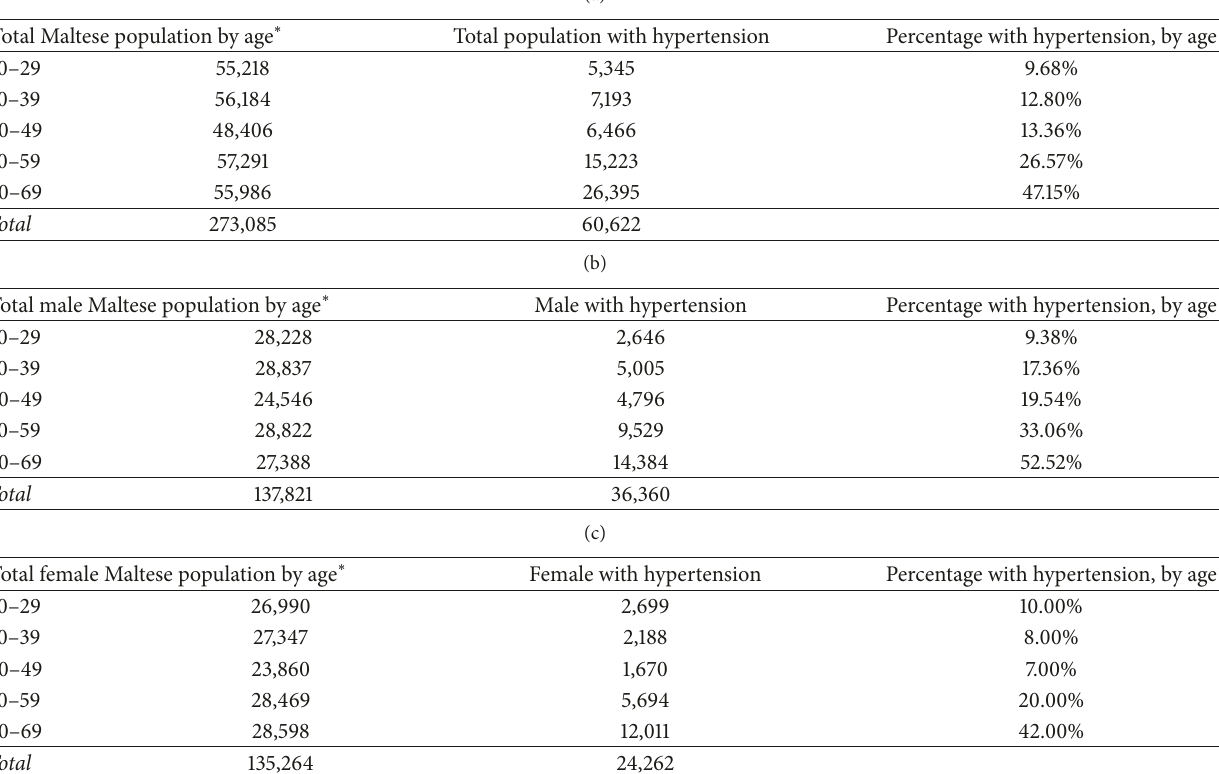
Table 1: Distribution of the estimated Maltese hypertension population, by age groups and gender.